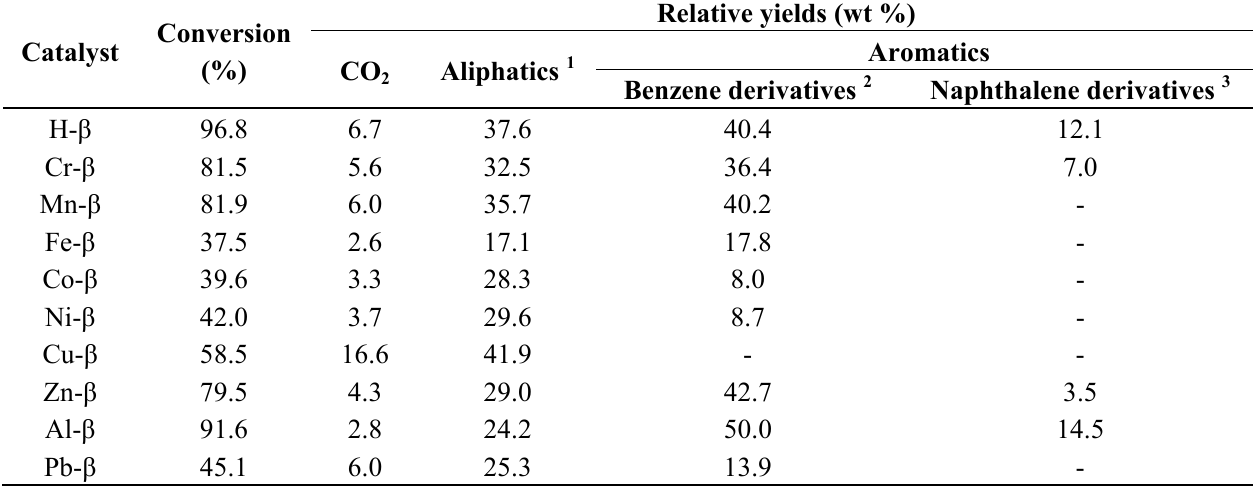
Table 3. Catalytic activity of metal exchanged β zeolites in the conversion of acetone at 400